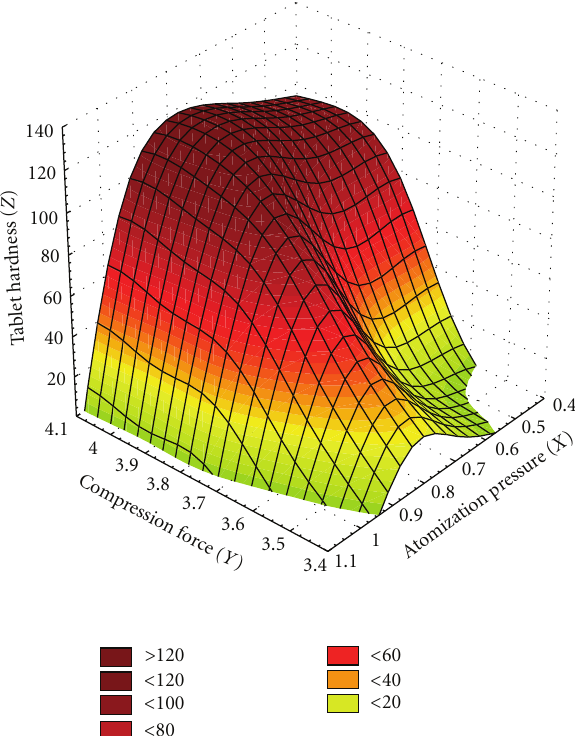
Figure 3: Tablets hardness changing in function of independent variables (atomization pressure and compression